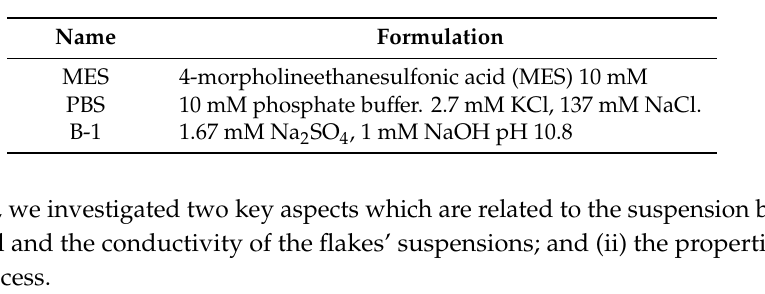
Table 1. Formulation of suspension bu ff